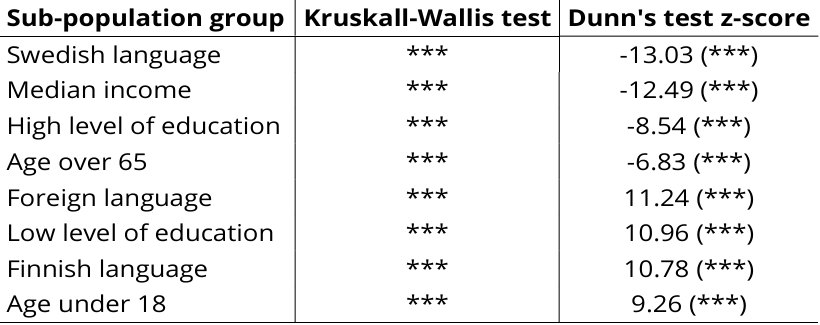
Table 2. Differences in distance to water areas among socio-economic and demographic residential clusters according to Kruskall-Wallis statistical test and Dunn's post hoc multiple pairwise comparison in the Helsinki Metropolitan Area